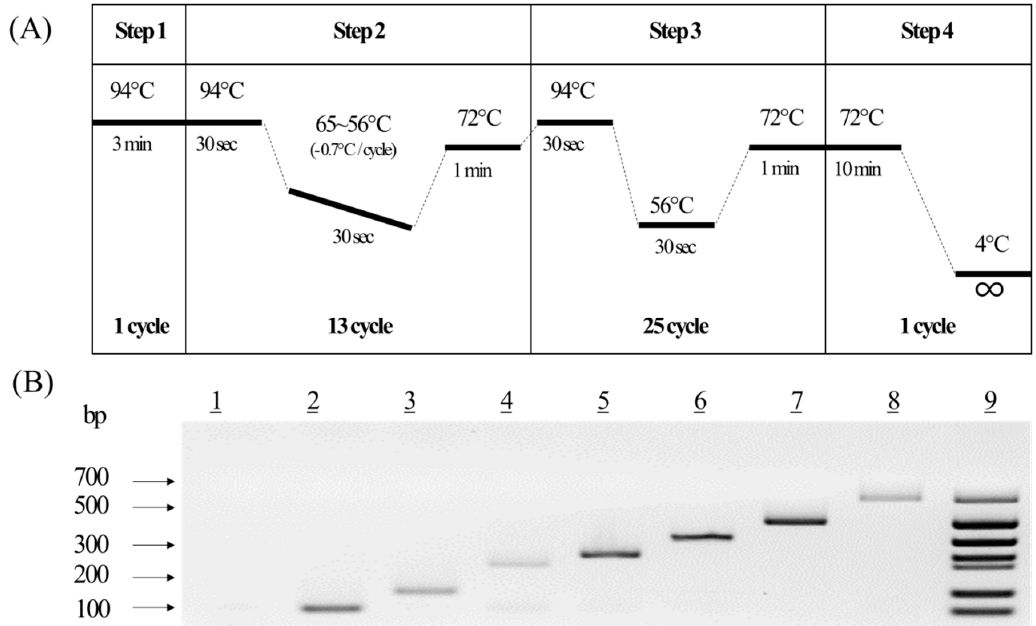
Figure 3. Establishment of a novel multiplex PCR for seven LM canola events. ( A ) Schematic diagram of the multiplex PCR conditions. ( B ) Agarose gel image of the products from the multiplex PCR method for the LM canola, in which each line indicates a non-LM PCR product (line 1), Topas 19/2 (line 2), Rf3 (line 3), Dp-073496-4 (line 4), Ms8 (line 5), GT73 (line 6), Mon88032 (line 7), T45 (line 8), and the multiplex PCR product (line 9).